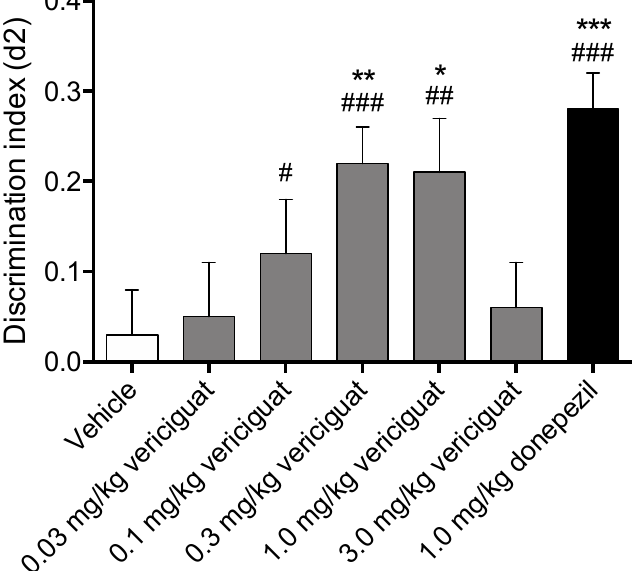
Figure 1. Dose–response curve of vericiguat on memory acquisition in the object location task. When compared with chance level (i.e., zero; d2 = 0), vericiguat administered 30 min before T1, improved memory performance at the doses of 0.1, 0.3 and 1.0 mg/kg. One-way ANOVA and subsequent post-hoc LSD t-tests revealed significant higher memory performance at 0.3 and 1.0 mg/kg vericiguat when compared to the vehicle condition. Reference compound donepezil was also administered 30 min before T1 and improved memory at 1.0 mg/kg, as indicated by both one-sample t-tests and one-way ANOVA and subsequent post-hoc LSD t -tests (comparison with vehicle). A difference from zero is depicted with hashes (One sample t-tests, #: p < 0.05; ##: p < 0.01; ###: p < 0.001) and a difference from the vehicle condition is depicted with asterisks (One-way ANOVA, LSD t -tests, *: p < 0.05; **: p < 0.01; ***: p < 0.001). The data are represented as mean +